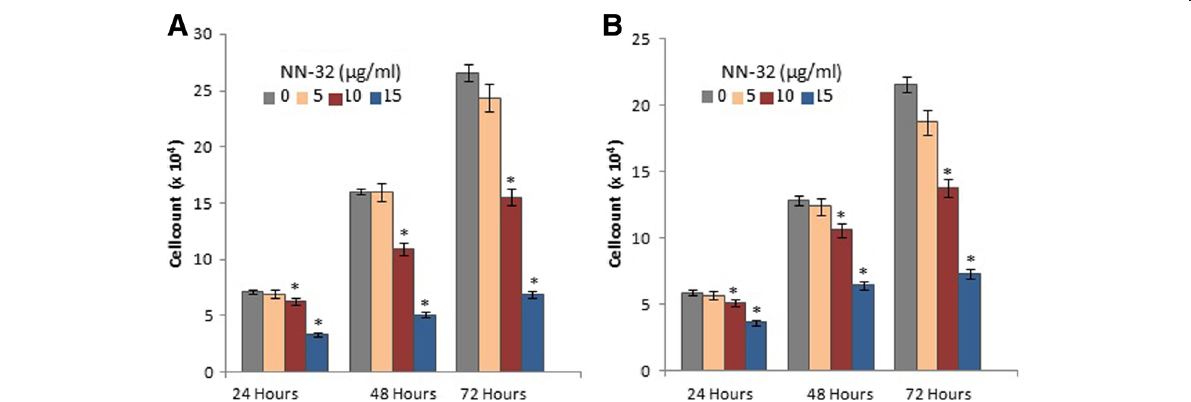
Fig. 6 Viability of Human breast cancer cells treated with NN-32 after 24, 48 and 72 h, ( a ) MCF-7 cell and ( b ) MDA-MB-231 cell. Values are expressed as mean ± Std. Dev ( n = 3). * p < 0.05 in comparison with the control group